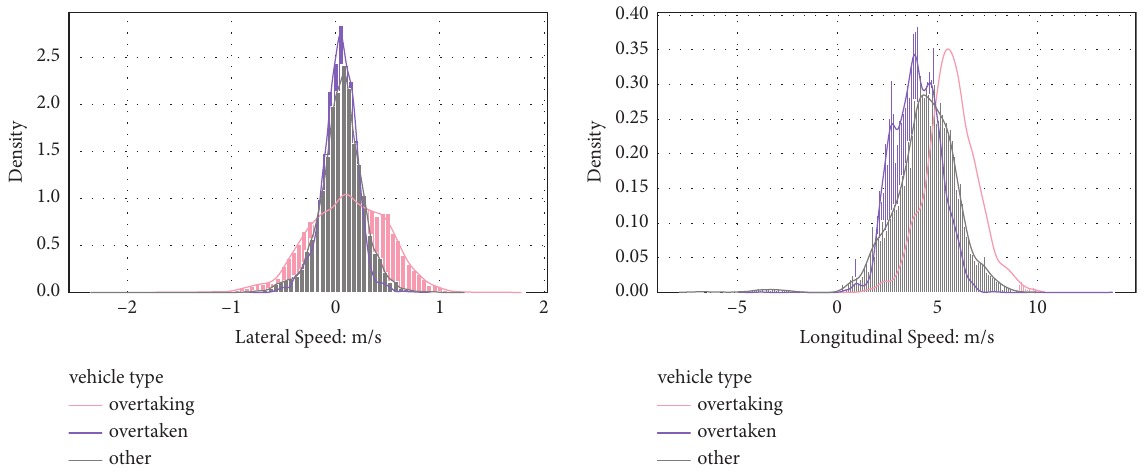
Figure 8: Speed distribution of different types of